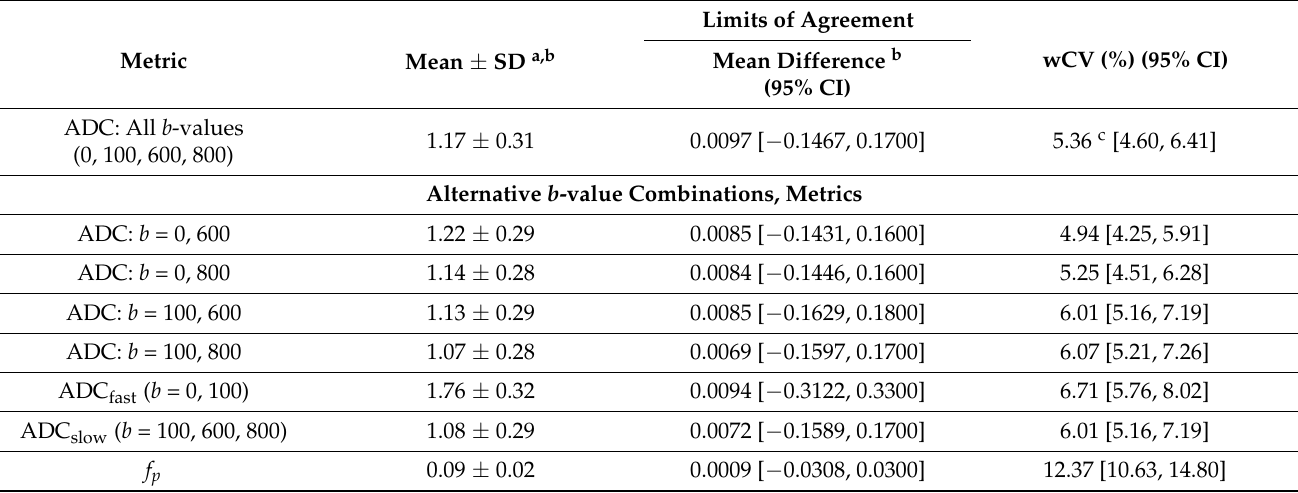
Table 5. Test–retest repeatability of ADC, f p measures by different b -value